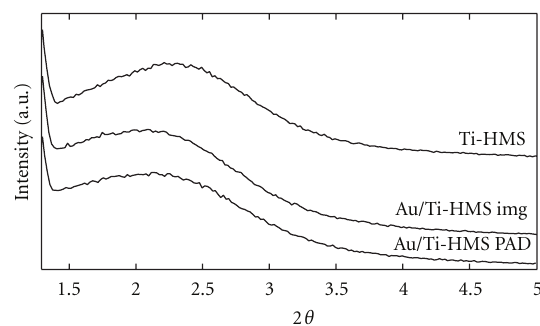
Figure 1: XRD patterns of Ti-HMS (A), PAD-Au/Ti-HMS (B) and img-Au/Ti-HMS (C).